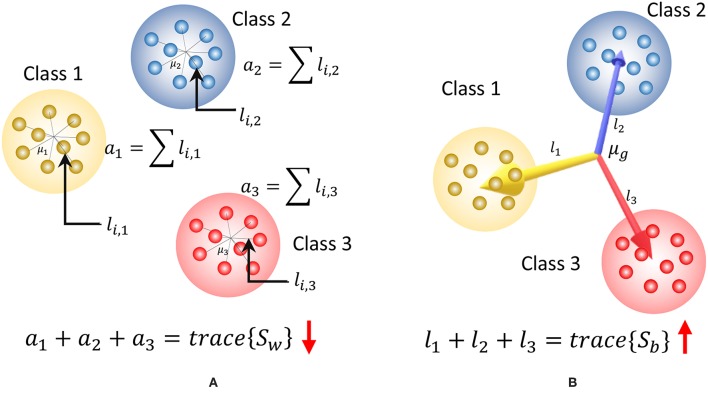
The graphical representation of the components of the discriminant ratio (DR) for a set of two dimensional data points that belongs to three classes. (A)
tr(Sw) gives a measure of the addition of all the squared distances from the class means to each data point. This must be lower to have better approximation property. Here li, j denotes the squared distance between the ith data point in class j to the class centroid, μj
(B)
tr{Sb} gives a measure of the addition of the squared distances between the global mean and each class mean. High value for tr{Sb} signals higher separation property. Here li denotes the squared distance from the global mean μg to the centroid of class i.